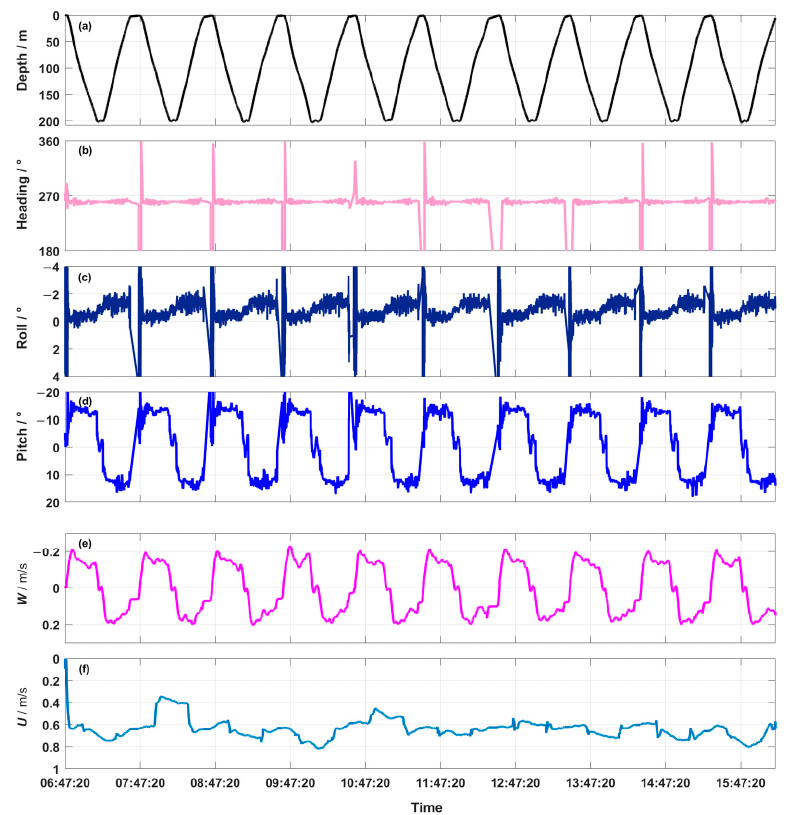
Figure 5. Flight performance of the hybrid AUV during the mission includes time series for ( a ) depth, ( b ) heading, ( c ) roll, ( d ) pitch, ( e ) W , and ( f ) U . The depth record shows the typical pattern with descent, cruise at 200 m, and ascent.